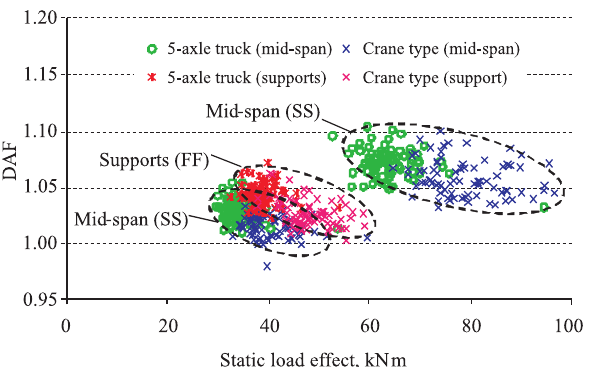
Fig. 10. Comparison of mean DAFs for 7.5 m span bridge and class B profile without bump